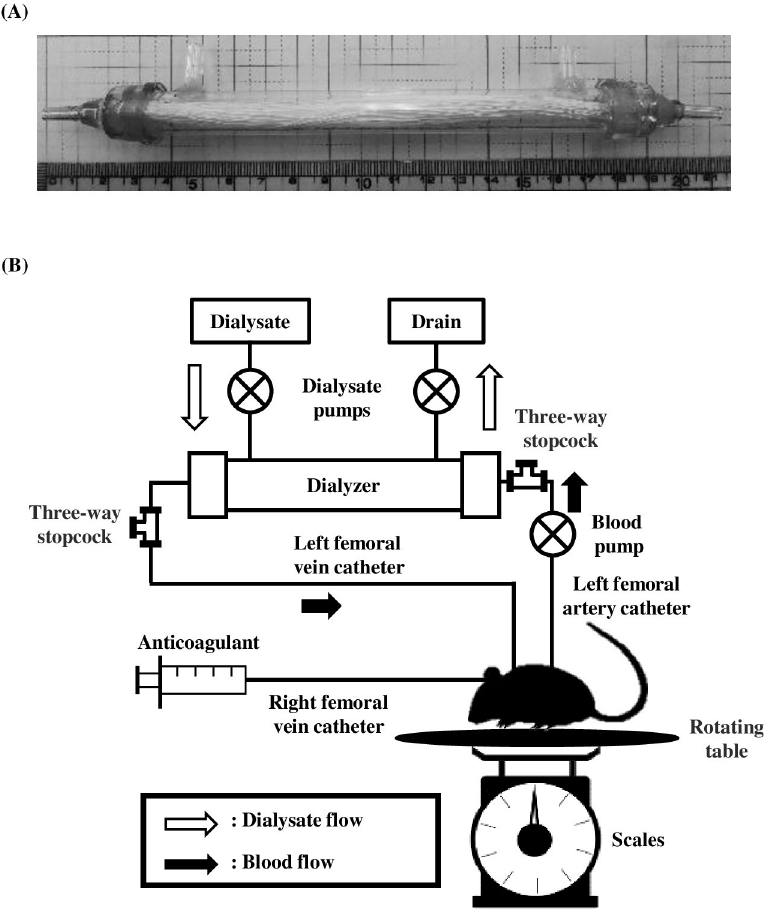
Fig 1. Construction of hemodialysis system using rat. The miniaturized dialyzer (A) and schematic diagram of the HD protocol (B) were shown. Miniature dialyzer contained PES membrane (113 cm 2 ) and was gamma sterilized. The renal failure model rat was prepared by bilateral renal nephrectomy. Heparin (100 U/mL) was administered as an anticoagulant with 0.2 mL/h flow rate. Blood pump was AC-2120 PERISTA 1 BIO-MINIPUMP. Dialysate pumps were AC-2120 PERISTA 1 BIO-MINIPUMP (inflow side) and Ceramic pump VSP-2050 (outflow side). right kidney was removed by incising the flank of the rat and ligating the right renal artery, vein and ureter. After the right kidney was removed, the left kidney was also removed in the same manner. The skin around the femur was incised and polyethylene tube catheters (PE No. 50, Becton, Dickinson and Company., Franklin Lakes, NJ, USA), filled with heparinized saline (100 IU/ mL), were indwelled in the left femoral artery, left femoral vein, and right femoral vein. The opposing ends of the catheters were exposed at the base of the neck under the skin. The indwelling catheters were connected to the blood circuit and the conscious rat under- went HD for 2 h, 18 h following the bilateral nephrectomy. The indwelling catheters of the left femoral artery and vein were connected to the three-way stopcocks of the blood circuit to col- lect the blood during HD. The indwelling catheter of the right femoral vein was used as a route of heparin administration during HD. The flow rate of the blood circuit and the dialysis fluid circuit were controlled by roller-pumps, with the blood flow and dialysate flow maintained at 1 mL/min and 5 mL/min, respectively. Sublood-BSG (bicarbonate buffer) was heated to 37˚C